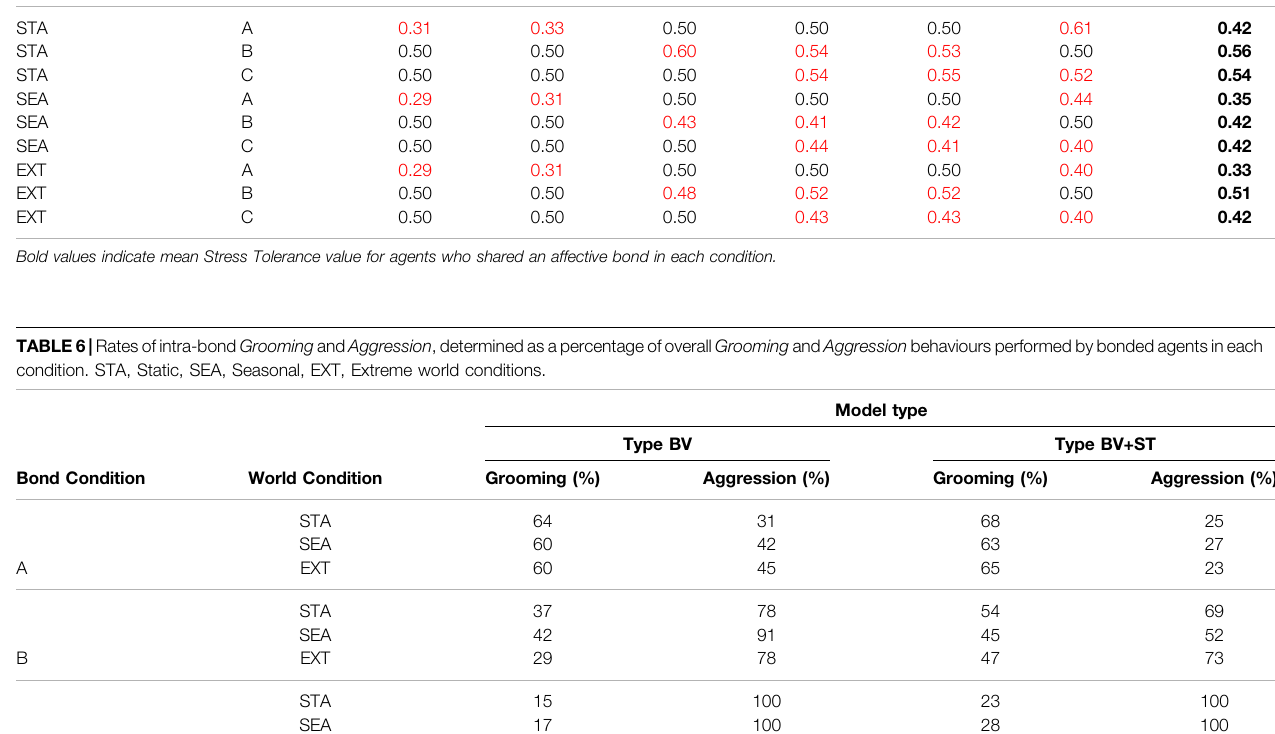
TABLE 5 | Mean values of the Stress Tolerance for bonded agent in Type BV+ST models, aggregated across all simulation runs. Default Stress Tolerance for unbonded agents = 0.5. Red cells highlight agents that shared an affective bond in those conditions. STA, Static; SEA, Seasonal; EXT, Extreme world conditions, respectively. World Condition